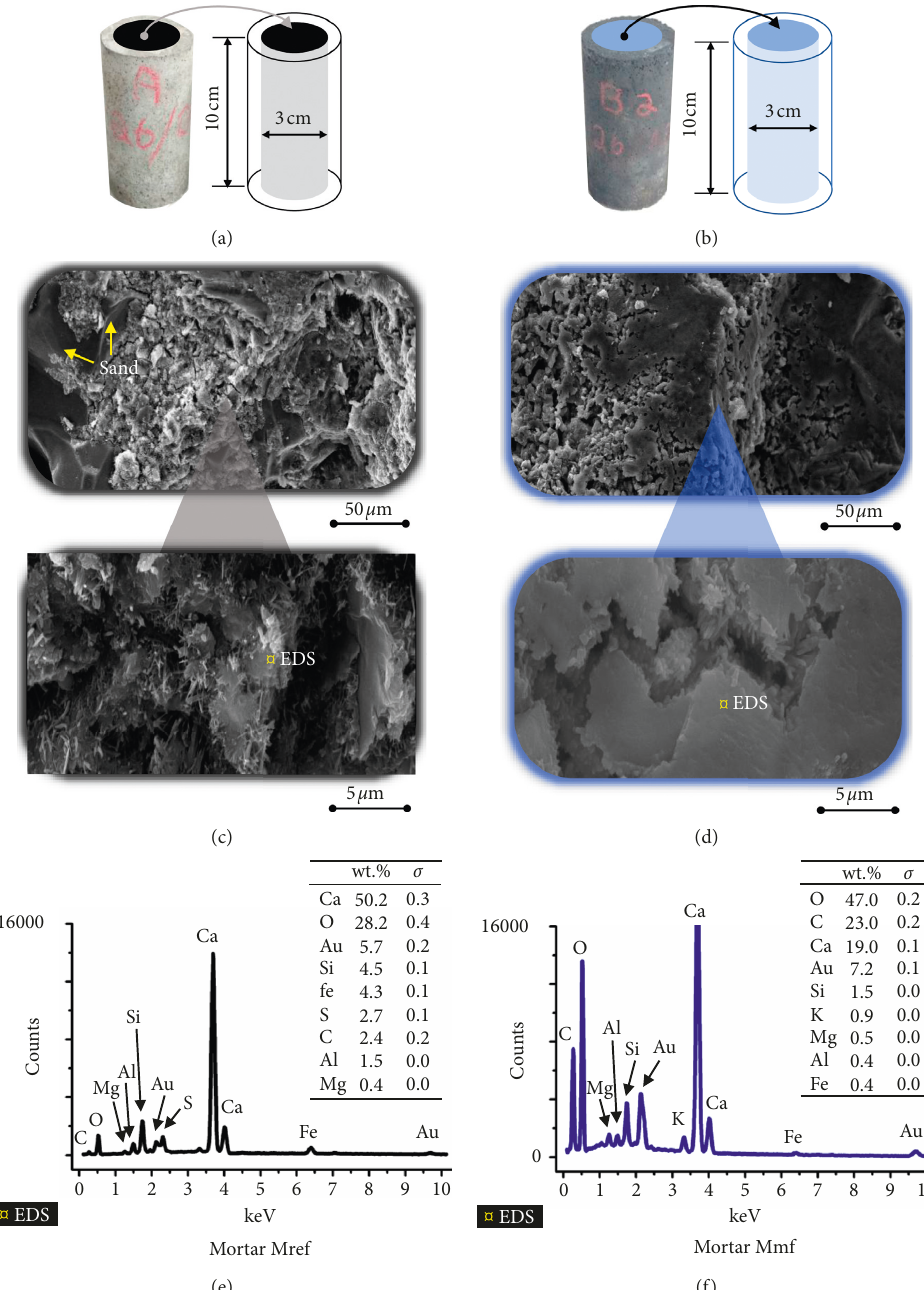
Figure 4: Unmolded mortar specimens after curing at 28days and SEM/EDS images. (a) Mref with indication of sampling point area, (b) Mmf with sampling point area, (c) SEM micrographs for Mref, (d) SEM micrographs for Mmf, (e) SEM/EDS images for Mref, and (f) SEM/ EDS images for